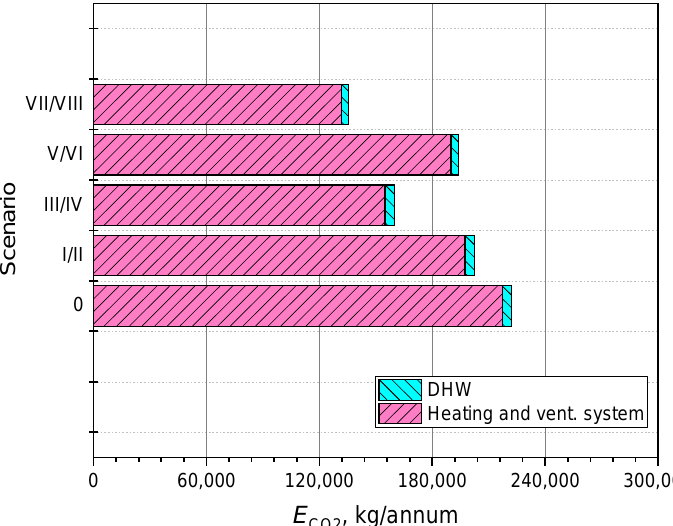
Figure 8. Environmental effect of thermal upgrading for the building and the scenarios: ‘0’—before; ‘I–VIII’—after thermomodernization (carbon dioxide).